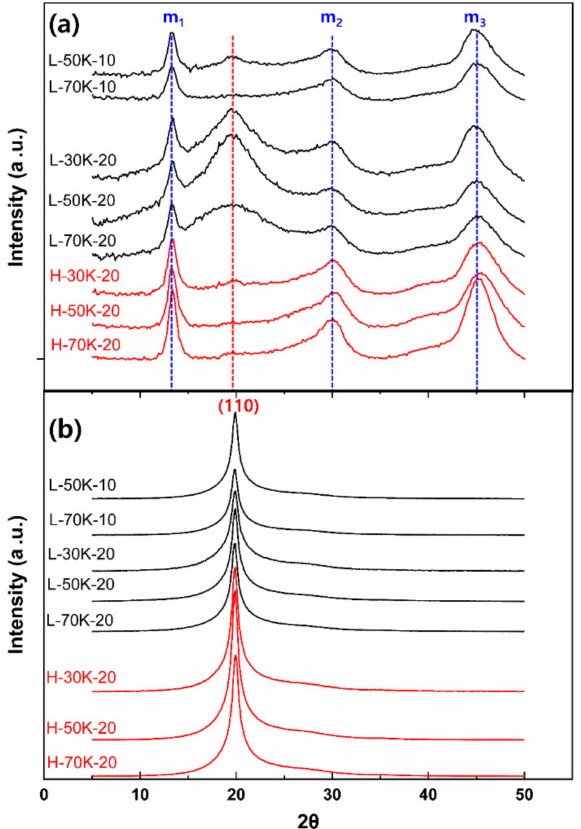
Figure 7. ( a ) Meridional and ( b ) equatorial intensity profiles extracted from the 2D-WAXD patterns of the as-spun TLCP fibers obtained at various spinning conditions.